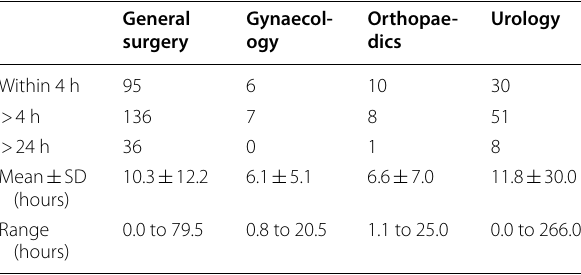
General Gynaecol- Orthopae- surgery ogy dics